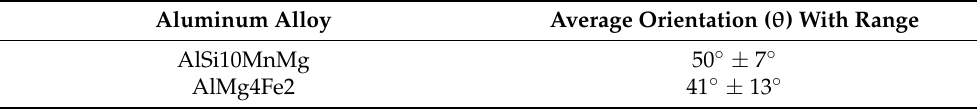
Table 2. Average and spread of the orientations of in-plane reaction resulting force with respect to the positive X-axis force.